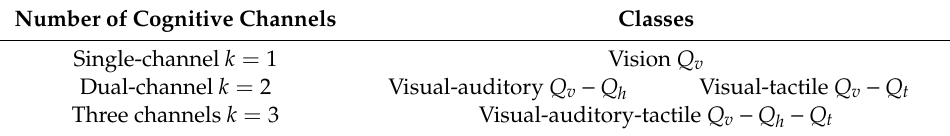
Table 2. Independent